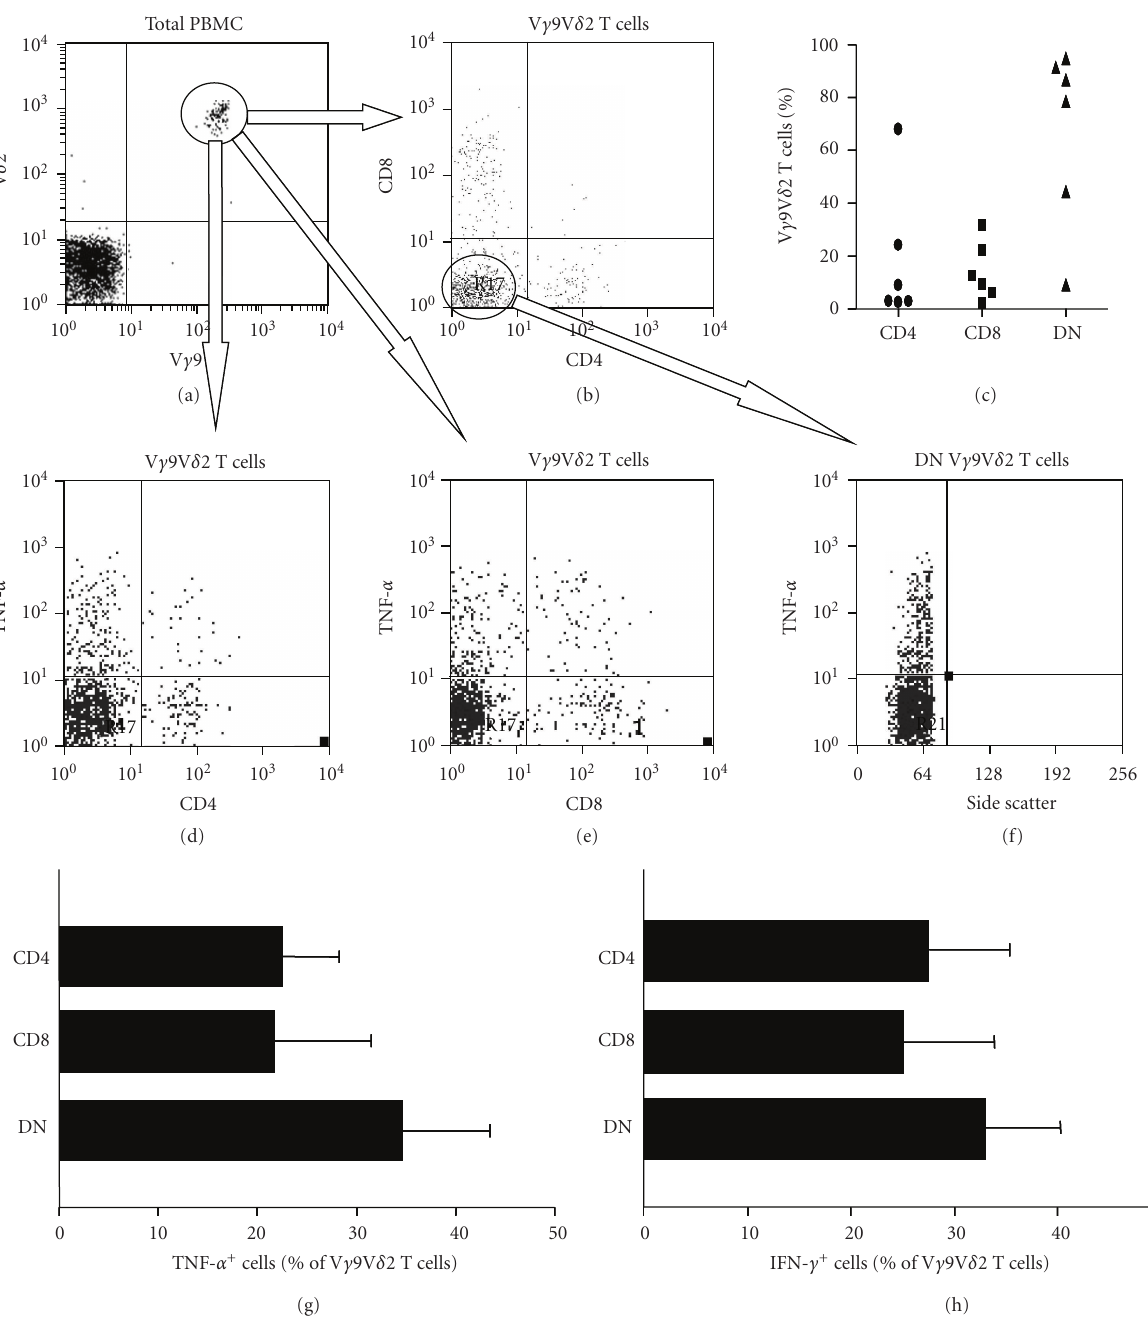
Figure 5: Cytokine expression by V γ 9V δ 2 cells is not influenced by CD4 or CD8 expression. PBMCs were stimulated with PMA and ionomycin and surface expression of V γ 9, V δ 2, CD4, and CD8, and intracellular expression of cytokines was analysed by flow cytometry after 4 hours. (a) V γ 9 + V δ 2 + cells were gated initially and (b) CD4 and CD8 expression by gated V γ 9V δ 2 T cells was analysed. (c) Mean frequencies of CD4 + , CD8 + , and double-negative (DN) V γ 9V δ 2 T cells from 6 donors. (d, e) Flow cytometry dot plots showing expression of TNF- α by CD4 + and CD4 − (d) and CD8 + and CD8 − (e) V δ 2V γ 9 T cells stimulated with PMA and ionomycin. (f) Dot plot showing expression of TNF- α by gated DN V γ 9V δ 2 T cells. Arrows show electronic gates used to generate dot plots. (g, h) Frequencies of CD4 + , CD8 + , and DN V δ 2V γ 9 T cell that produced TNF- α (g) and IFN- γ (h) in response to stimulation with PMA and ionomycin. Results are means of 5 independent